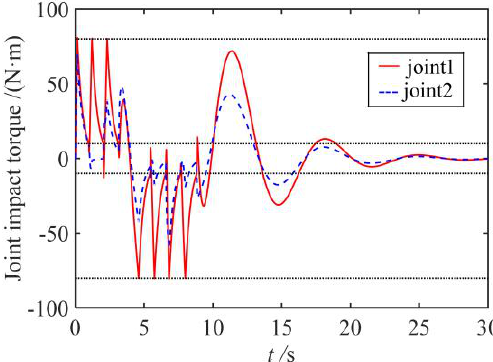
Figure 15. Joint impact torque (